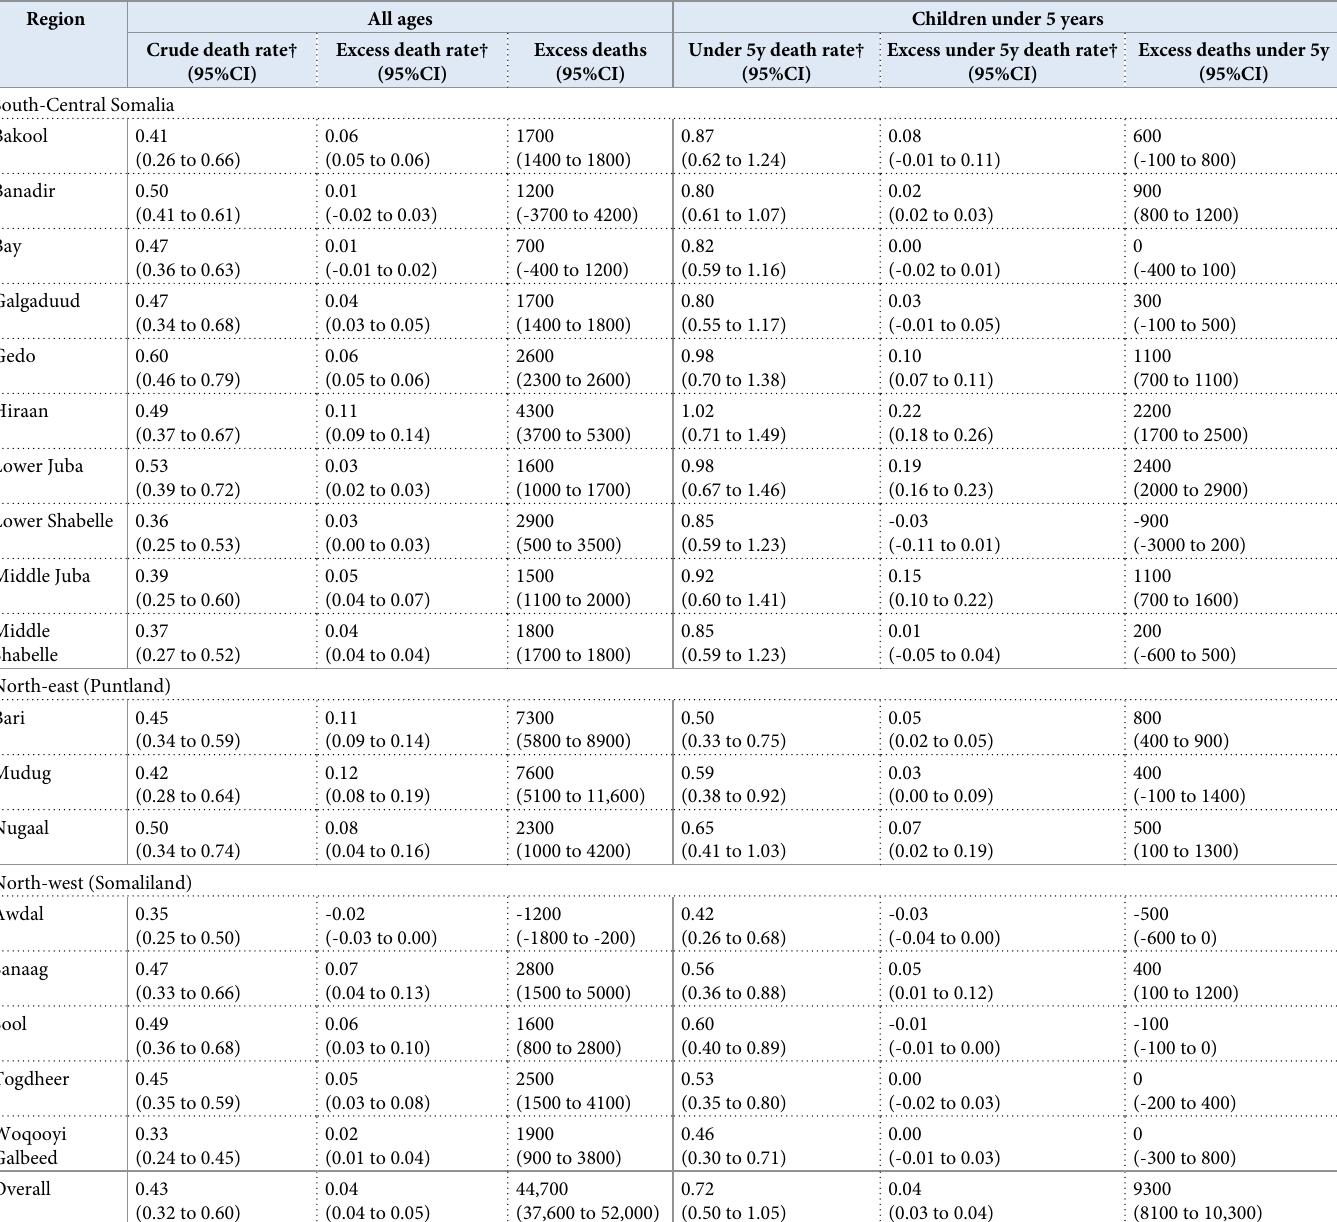
Table 6. Crude death rate, excess death rate and excess death toll by region, under the most likely counterfactual scenario, for all ages and children under 5 years.